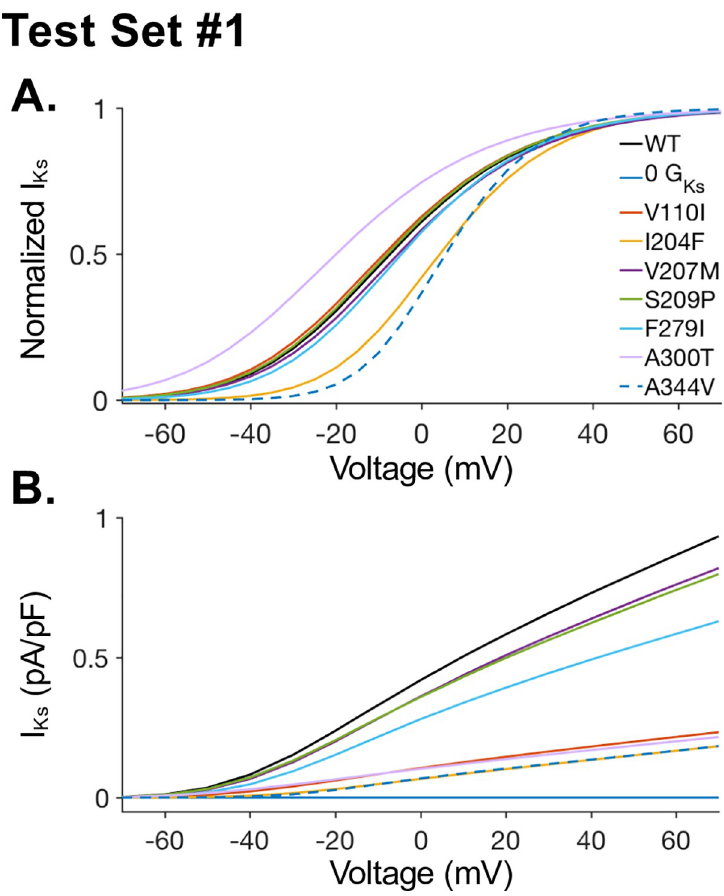
Fig 1. Model optimization to test set 1 data. The iPSC-CM I Ks model was optimized to experimental data for KCNQ1 mutations in test set 1 (TS1). TS1 includes only mutations with known clinical phenotypes. Experimentally observed change relative to the wild-type in Vanoye et al. was used to fit each mutant I Ks model [1]. Models were optimized to data for V 1/2 , k, and current density. (A) Steady-state activation curves and (B) Current-voltage (I-V) relationships are shown for each mutant model in TS1. Additionally, complete I Ks block (G Ks = 0) was included to represent mutations resulting in insufficient current density to allow measurement. Complete block is not included in panel A, for